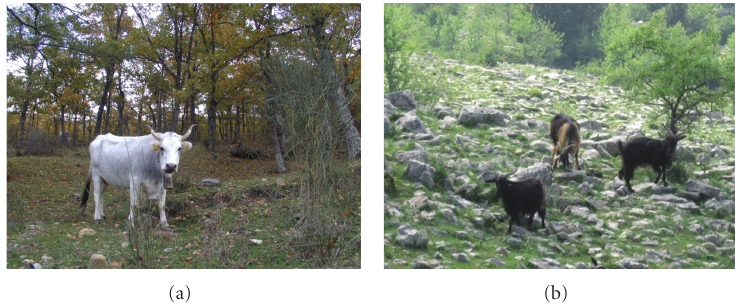
Figure 2: Cattle and goats grazing in the Collina Materana forests.